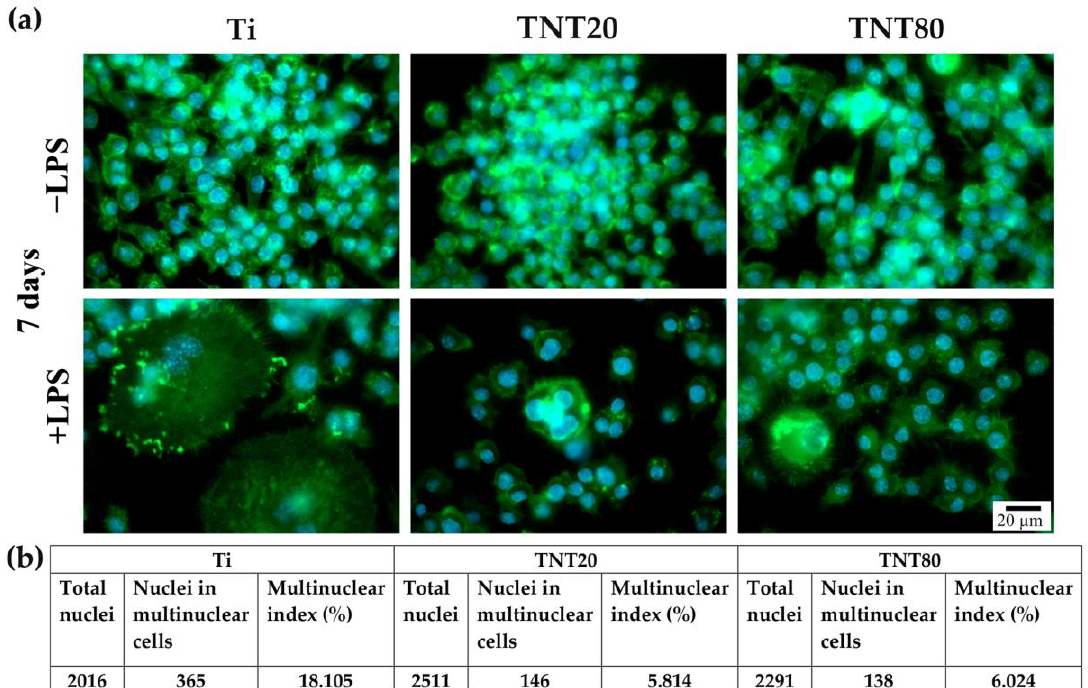
Figure 6. Fluorescent images of multinucleated FBGCs in direct contact with the tested surfaces at 7 days post-seeding: ( a ) Comparative fluorescent microscopy images of non-stimulated (−LPS) and stimulated (treatment with 100 ng mL −1 LPS) cells that indicate major morphological alterations on the flat Ti support in comparison to the TNTs surfaces and differences in terms of number, size, and cytoskeleton organization of the multinucleated cells under LPS stimulation. Moreover, the unstimulated cells presented a typical round morphology characteristic to this cell line without exhibiting cell fusion phenomenon. Cells were labeled with phalloidin coupled with Alexa Flour 488 (green fluorescence) and the nuclei were stained in blue with DAPI. All images were captured at the same magnification (scale bar represents 20 µm). ( b ) The “multinuclearity index” was calculated by examining 15–17 suggestive microscopical fields-of-view for each sample.